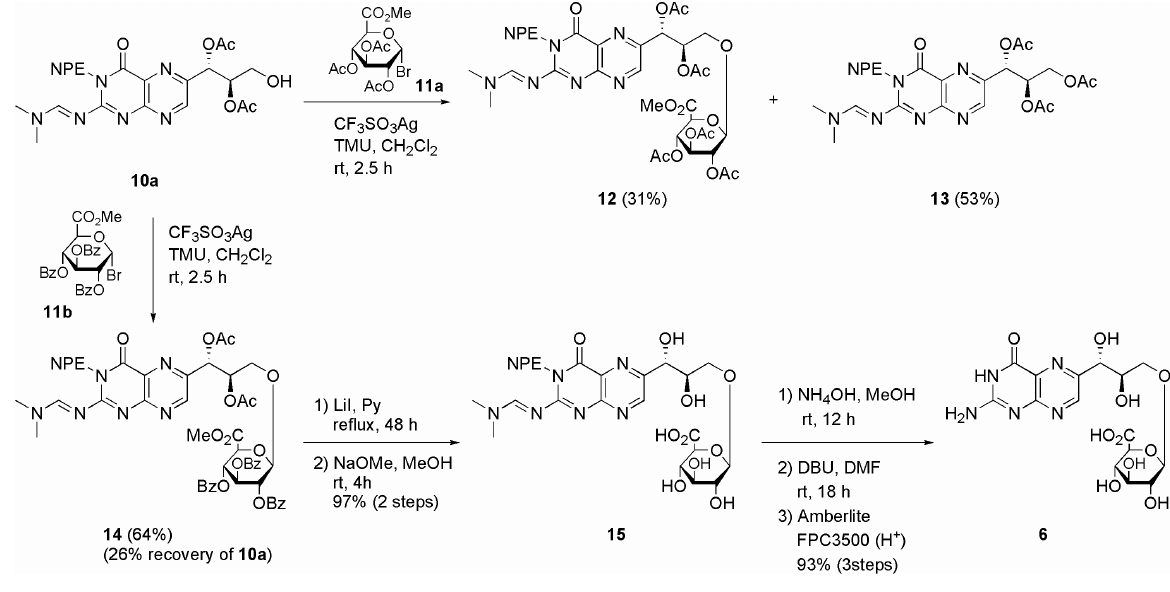
Table 1: 600 MHz 1 H- and 151 MHz 13 C-NMR Spectral parameters for 3'- O -( β